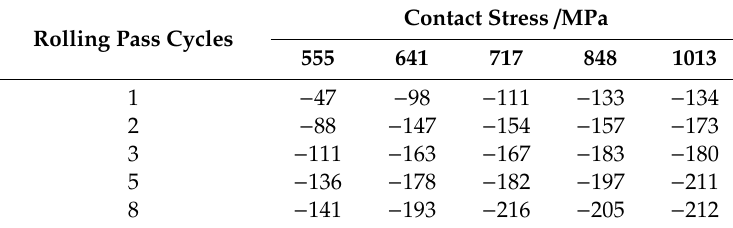
Table 2. Surface residual stress data of rolled specimens